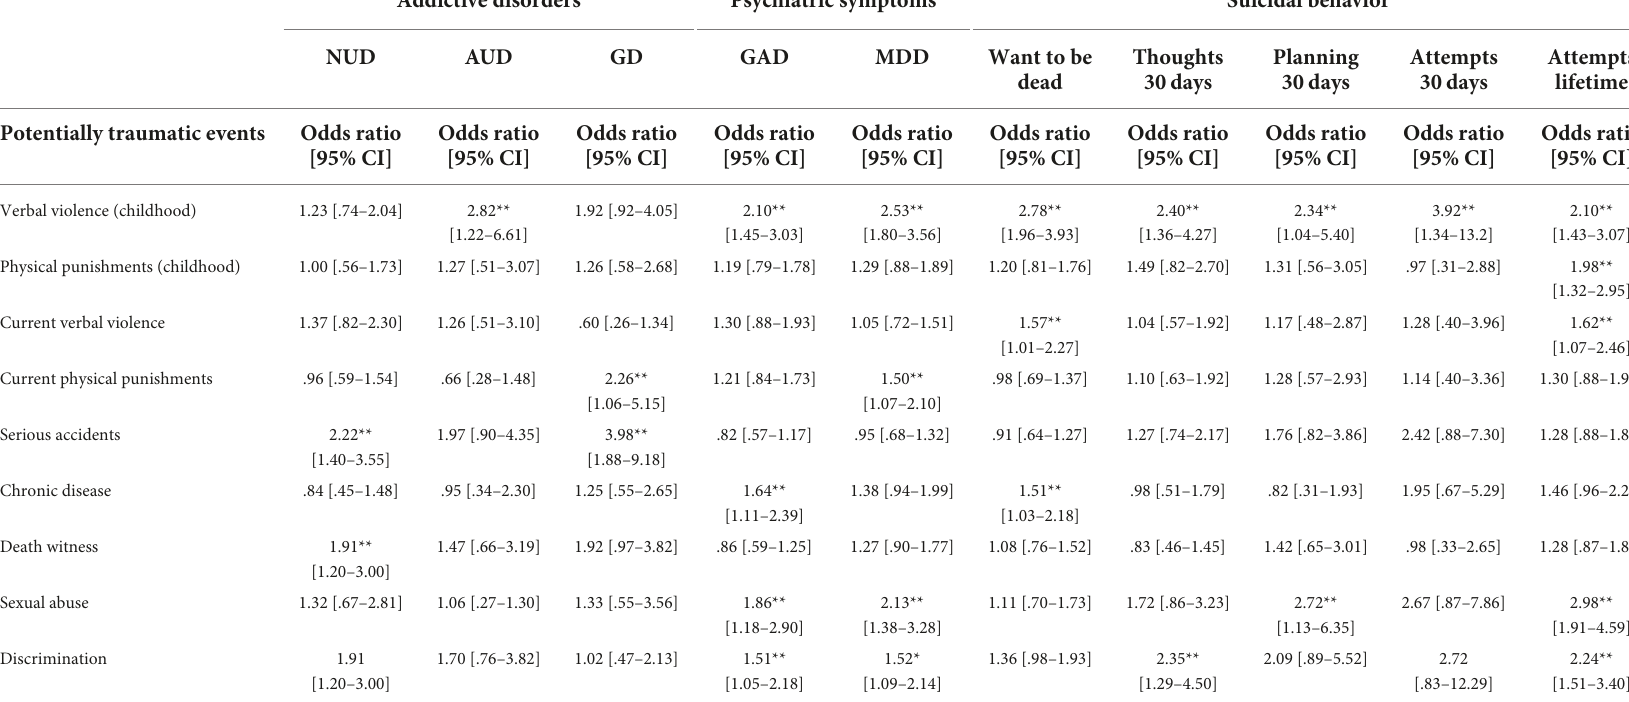
TABLE 3 Odds ratio between potentially traumatic events (PTEs) by addictive disorder, psychiatric symptoms, and suicidal